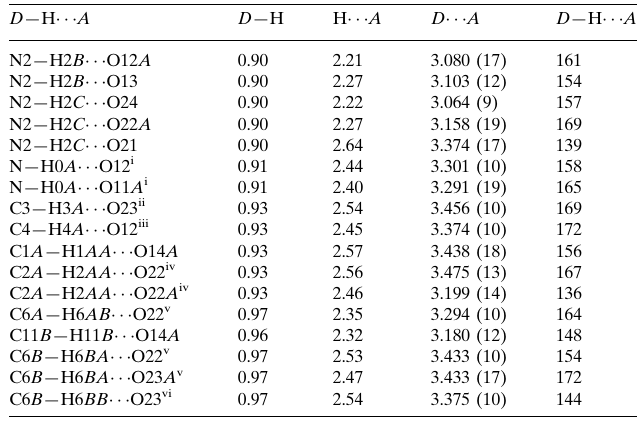
Hydrogen-bond geometry (A˚ , (cid:2)